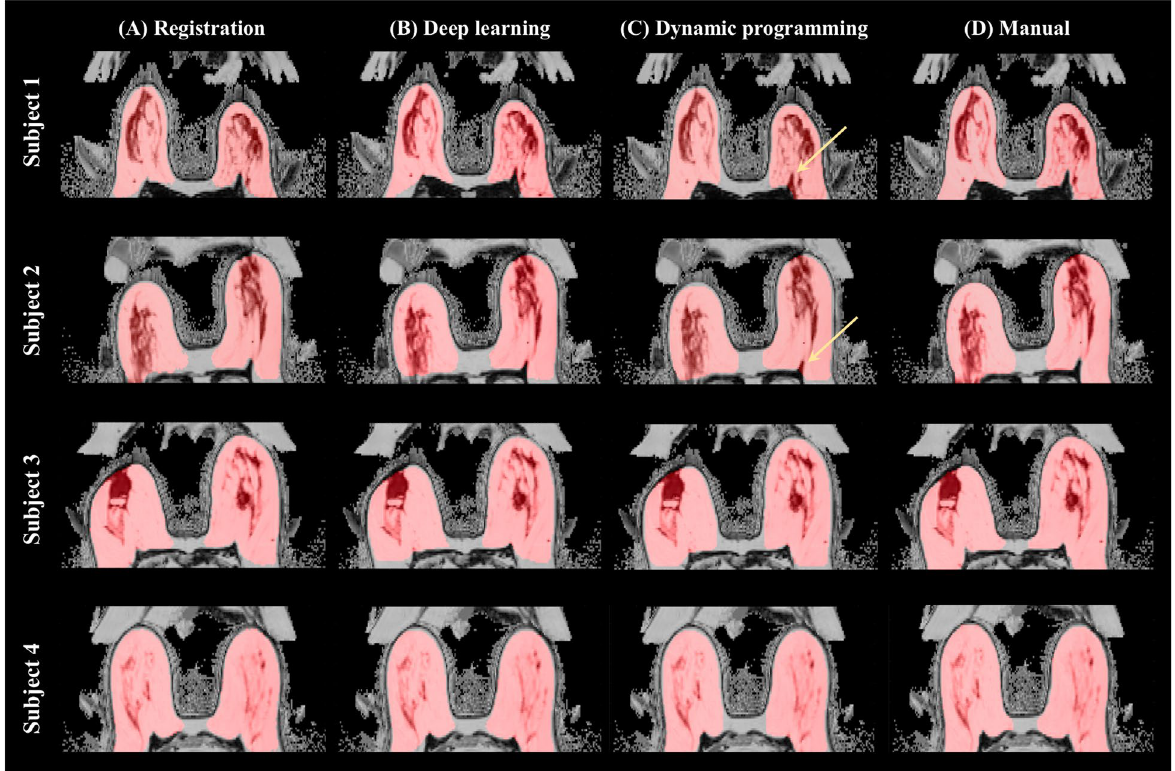
Fig. 4 Representative examples of whole‑breast segmentation results using A registration, B deep learning, C dynamic programming, and D manual methods